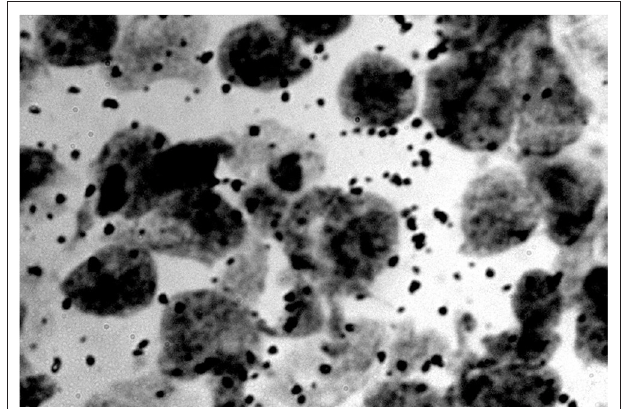
FIGURE 6 | RNA dots related to the neuron nucleus (rats) (Jovanovi´c, 2001; Jovanovi´c et al., 2014).